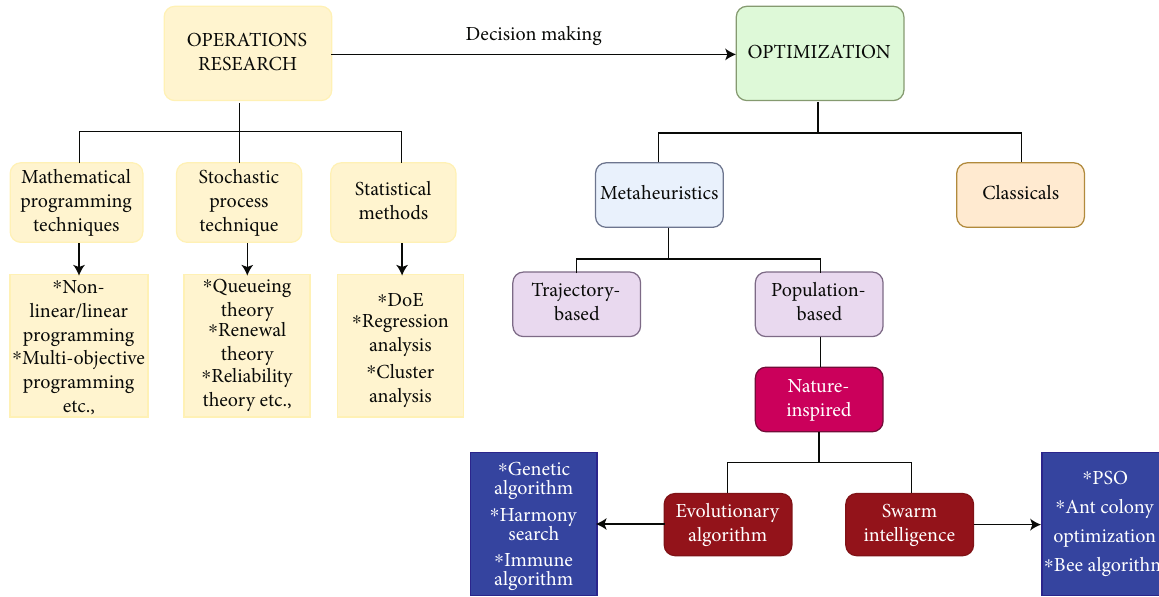
Figure 1: Classi fi cation of optimization techniques